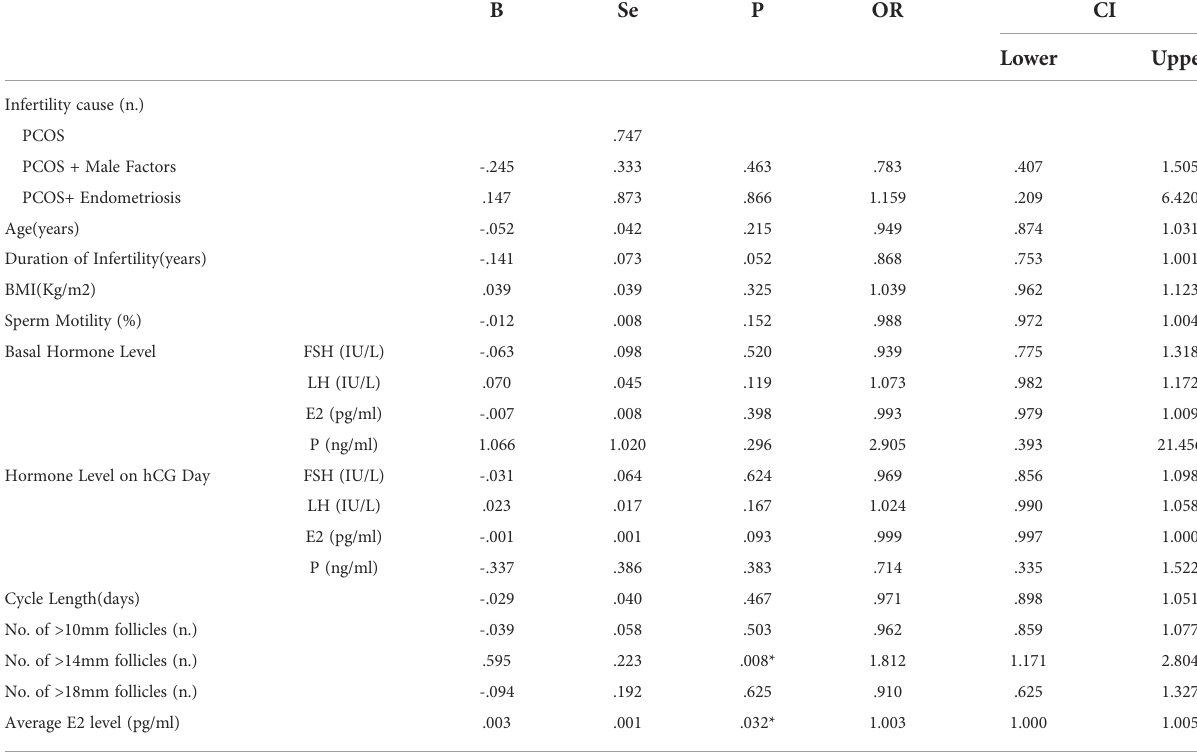
TABLE 6 Logistic regression analysis for pregnancy outcomes of PCOS patients undergoing IUI with >3 previous OI cycles. B Se